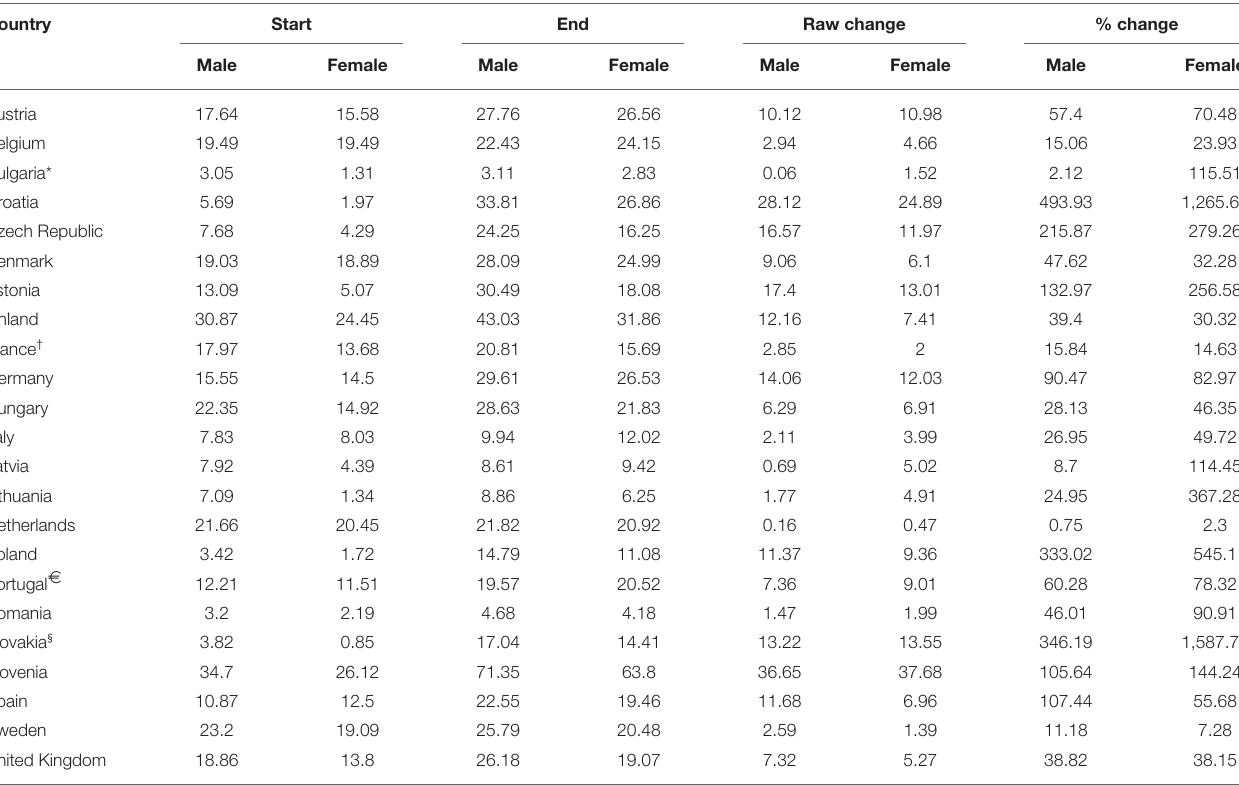
TABLE 1 | Change in age-standardised death rates from non-rheumatic aortic stenosis for those aged > 45 years in Europe from 2000 to 2017. Country Start